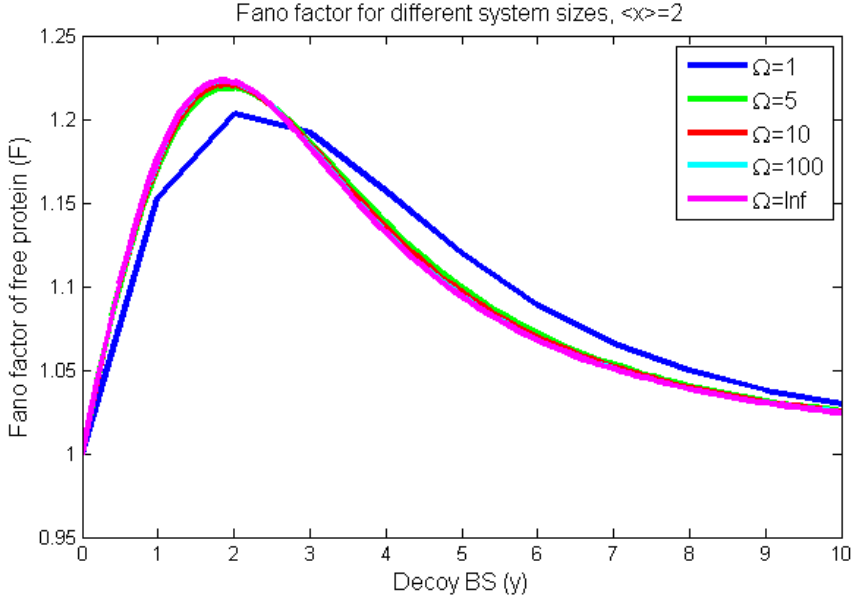
Fig. 8: Fano factor for different system